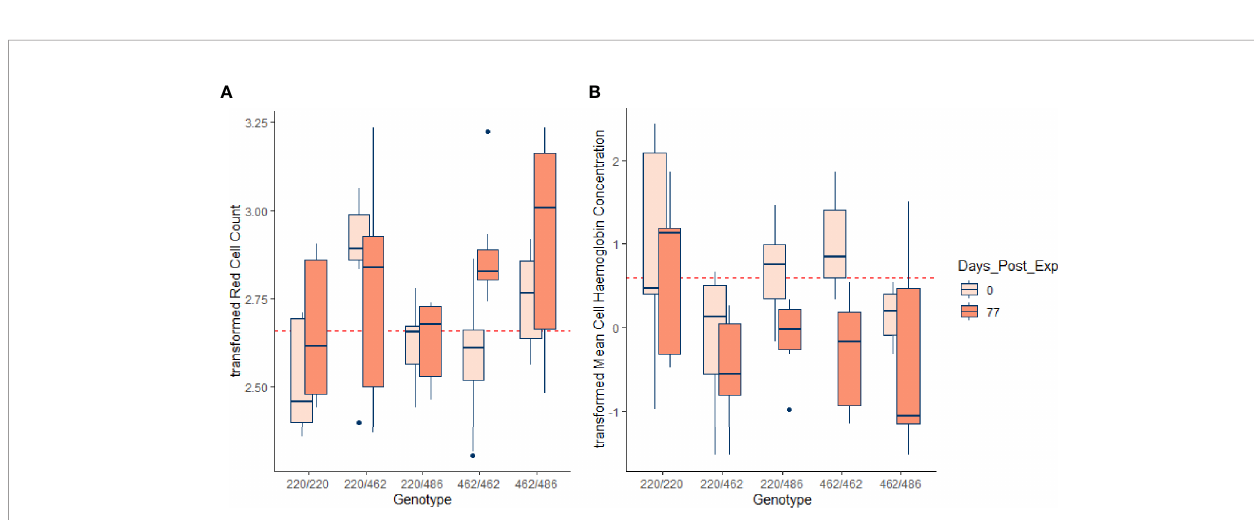
FIGURE 4 | Transformed RCC (tRCC - A ) and transformed MCH (tMCH - B ) for the initial (pre-infestation) and end (77 d post-infestation) time points, for each of the genotypes. Horizontal dotted lines in red are the mean pre-infestation values for each of the transformed variables. For RCC, the effect of 462 allele dosage was highly signi fi cant in the GAM ( p < 0.00083, Table 5 ) but for MCH the effect approached signi fi cance ( p = 0.00726, Table S1